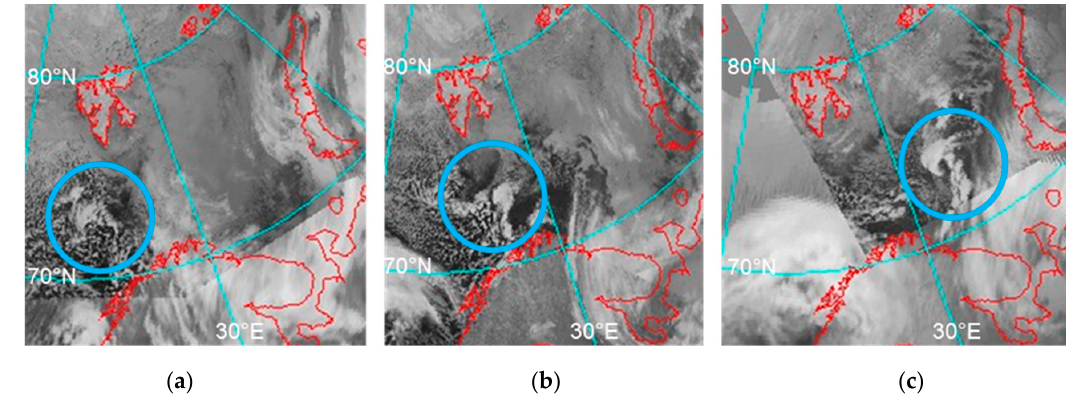
Figure 10. Consecutive satellite images of the polar low, which originated on 24 February 2020 off the coast of Svalbard: ( a ) 14:00 UTC 24.02; ( b ) 09:00 UTC 25.02; ( c ) 04:00 UTC 26.02. Images available from the Antarctic Meteorological Research Center (AMRC).